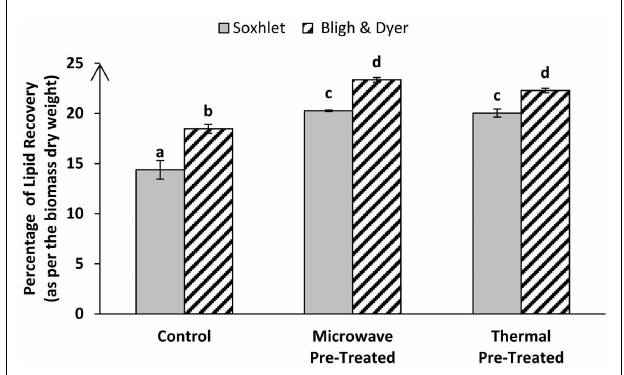
FIGURE 4 | Percentage of total lipid recovery per dry weight from Tetraselmis sp. M8 algal biomass through Bligh & Dyer and Soxhlet extraction of pre-treated or untreated (control) samples . Different letters represent significant statistical differences ( P <